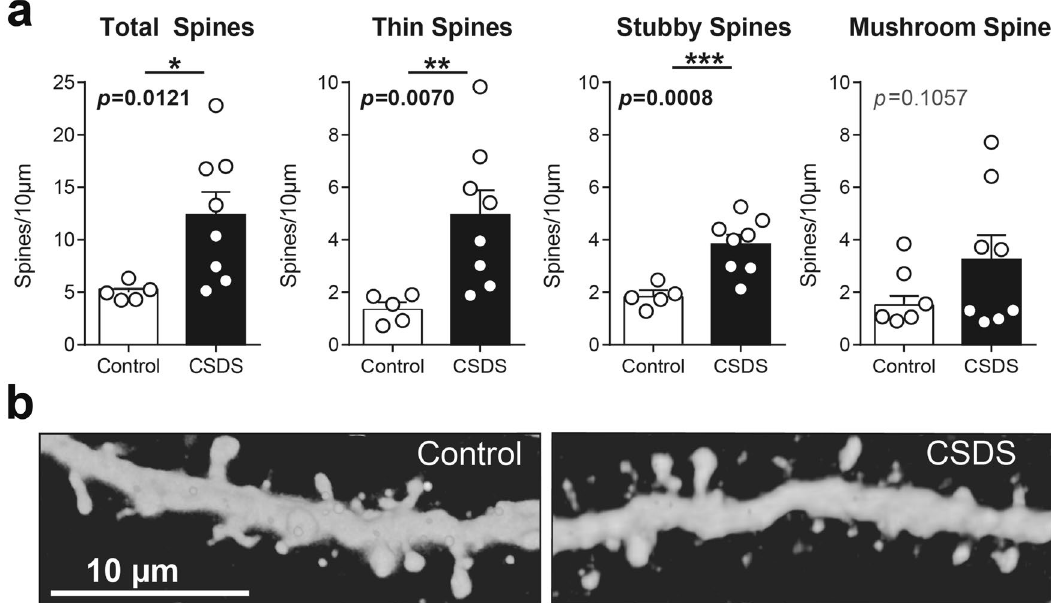
Figure 2. ( a ) Spine density in unstressed control and socially defeated mice, and broken down by spine type. Each individual data point represents the average of 3–4 dendrites per cell, from 3–4 cells in an individual mouse (9–15 total dendrites per mouse) ( b) Representative dendritic segments from control and CSDS mice. *P < 0.05, **P < 0.01, ***P < 0.005, Welch’s corrected T-test.